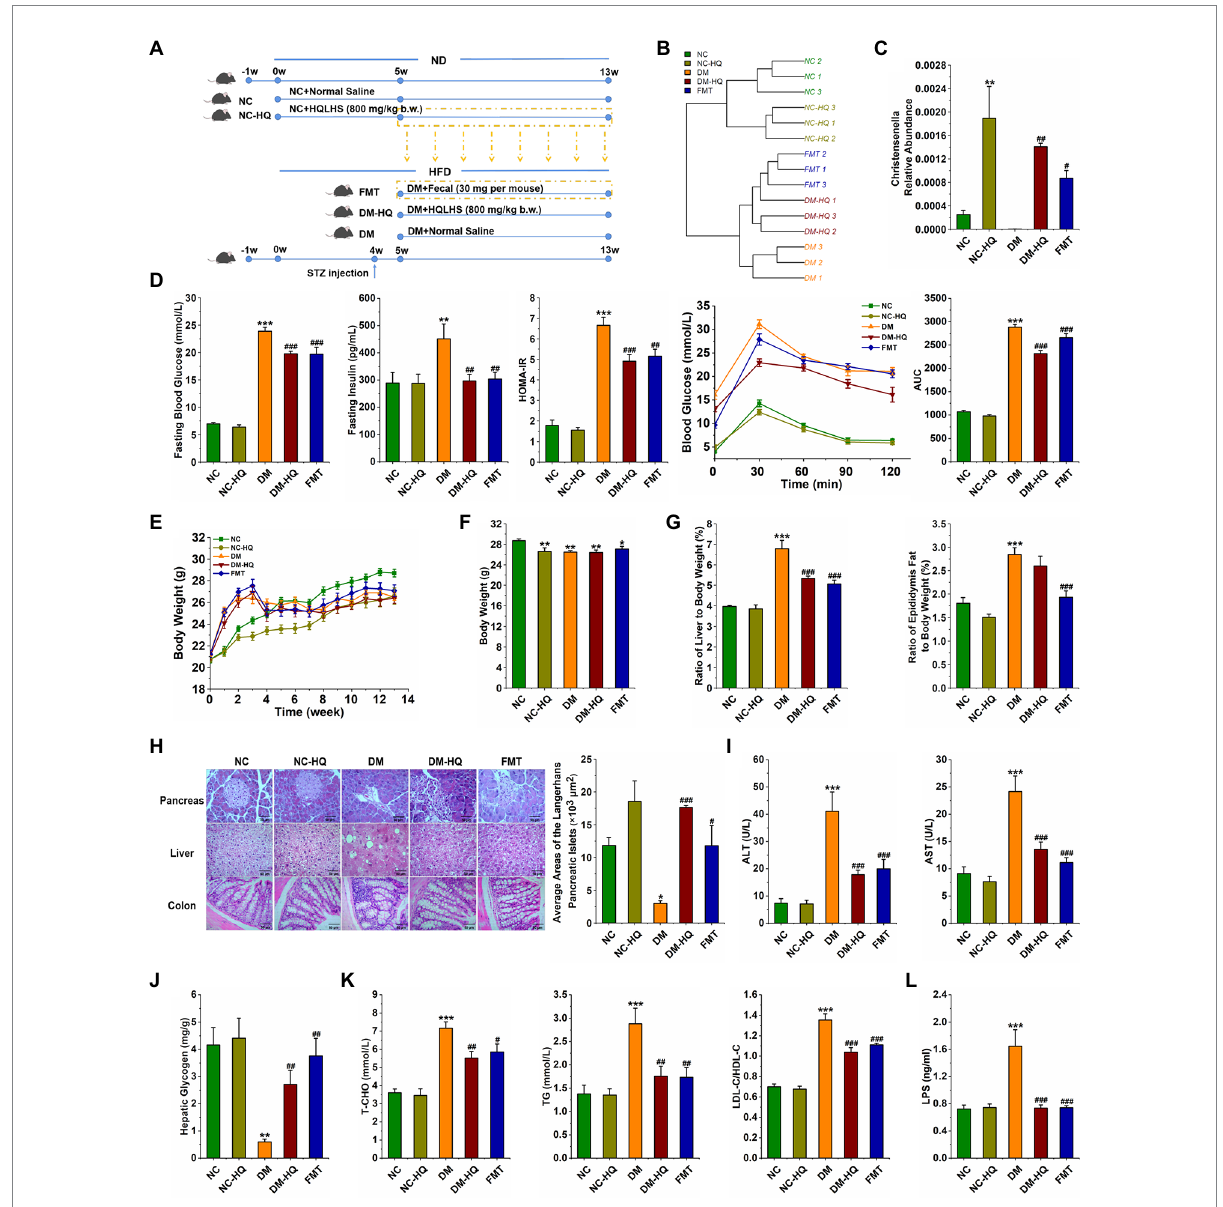
FIGURE 4 Treatment with fecal microbiota alleviated HFD and STZ induced type 2 diabetes. (A) Experimental design. (B) Hierarchical clustering tree of the cecum microbiota. (C) Relative abundance of Christensenella of five groups at week 13. (D) Fasting blood glucose, serum level of fasting insulin, HOMA-IR, OGTT test, and area under the curve (AUC). (E) The weekly weight changes. (F) Body weight at week 13. (G) The ratio of epididymis to body weight and the ratio of liver to body weight, respectively. (H) Morphological observation of pancreas (magnification, ×200, 50 μ m), liver (magnification, ×200, 50 μ m), colon (magnification, ×400, 50 μ m) with H&E staining, and the average area of the pancreatic islets of Langerhans. (I) Serum ALT and AST levels. (J) Liver glycogen level. (K) Serum triglycerides, the total cholesterol, LDL-C/HDL-C levels. (L) Serum LPS level. Data are expressed as mean ± SEM; One-way ANOVA was used to analyze statistical differences; Compare to NC: * p < 0.05; ** p < 0.01; and *** p < 0.001; Compare to DM: # p < 0.05; ## p < 0.01; and ### p <